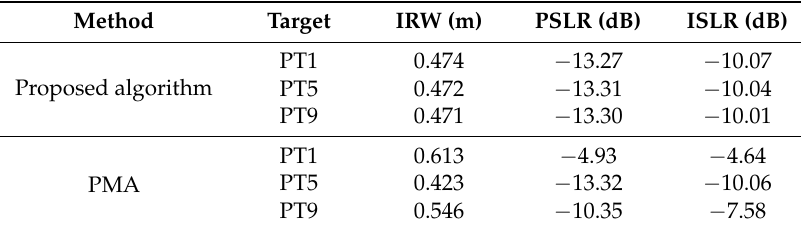
Figure 10. Simulation results: ( a ) comparative results of azimuth profiles of PT1 by PMA and the proposed algorithm; ( b ) comparative results of azimuth profiles of PT5 by PMA and the proposed algorithm; ( c ) comparative results of azimuth profiles of PT9 by PMA and the proposed algorithm. Table 3. Imaging quality parameters in Simulation Case